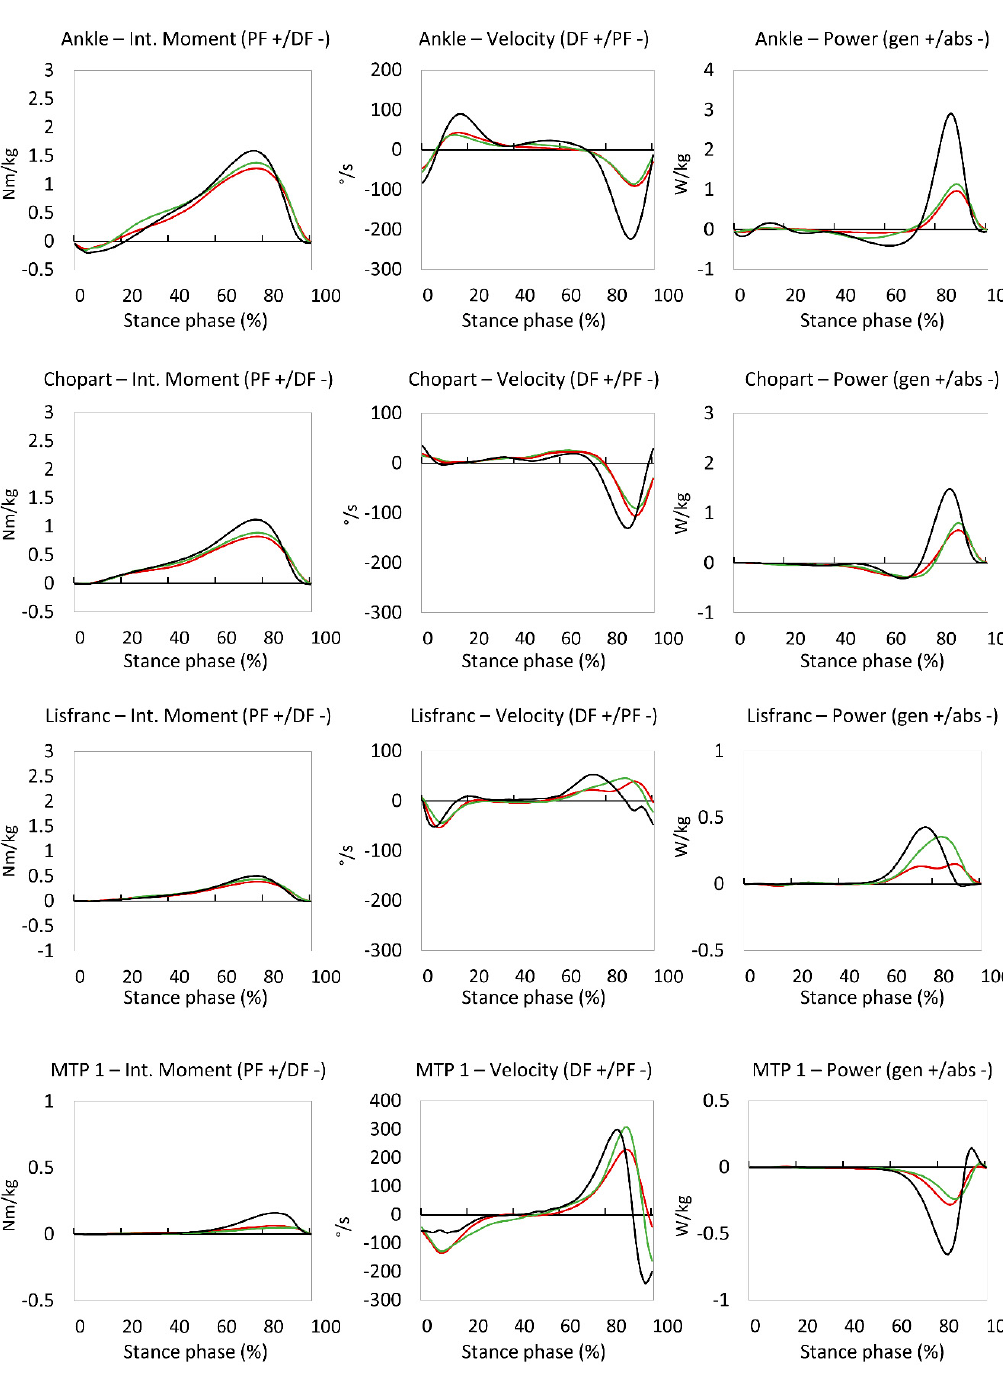
Figure 2. Control (dot / dashed line), pre-operative (dashed line), and post-operative (full line) kinetic waveforms of the ankle joint ( upper ), as well as the Chopart (second row), Lisfranc (third row), and MTP 1 ( lower ) joints. PF: plantar flexion; DF: dorsal flexion; gen: generation; abs: absorption.